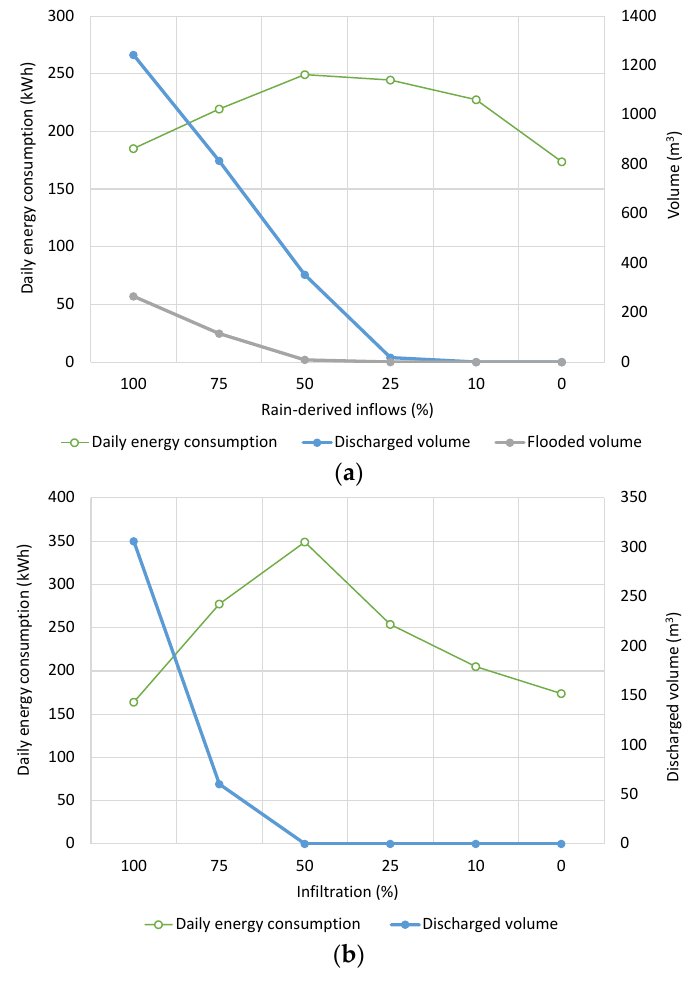
Figure 8. Impact of UI in energy consumption and in discharged and flooded volumes associated with ( a ) rain-derived inflows and ( b ) infiltration (no flooding occurrence).